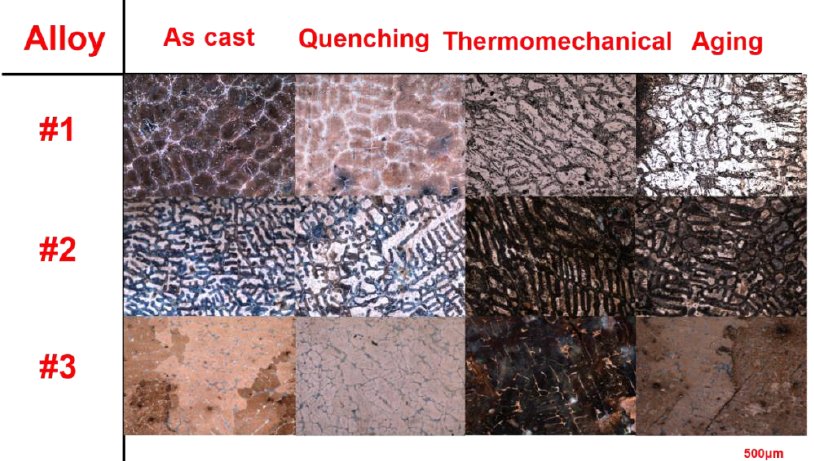
Figure 11. Metallographic structure changes in the four alloys during heat treatment. Alloys were heated from 20 to 1000 °C for 30 min, cooled by water (20 °C) re-heated to 1000 °C for 30 min, and after rolling, aging 72 h in 200 °C.